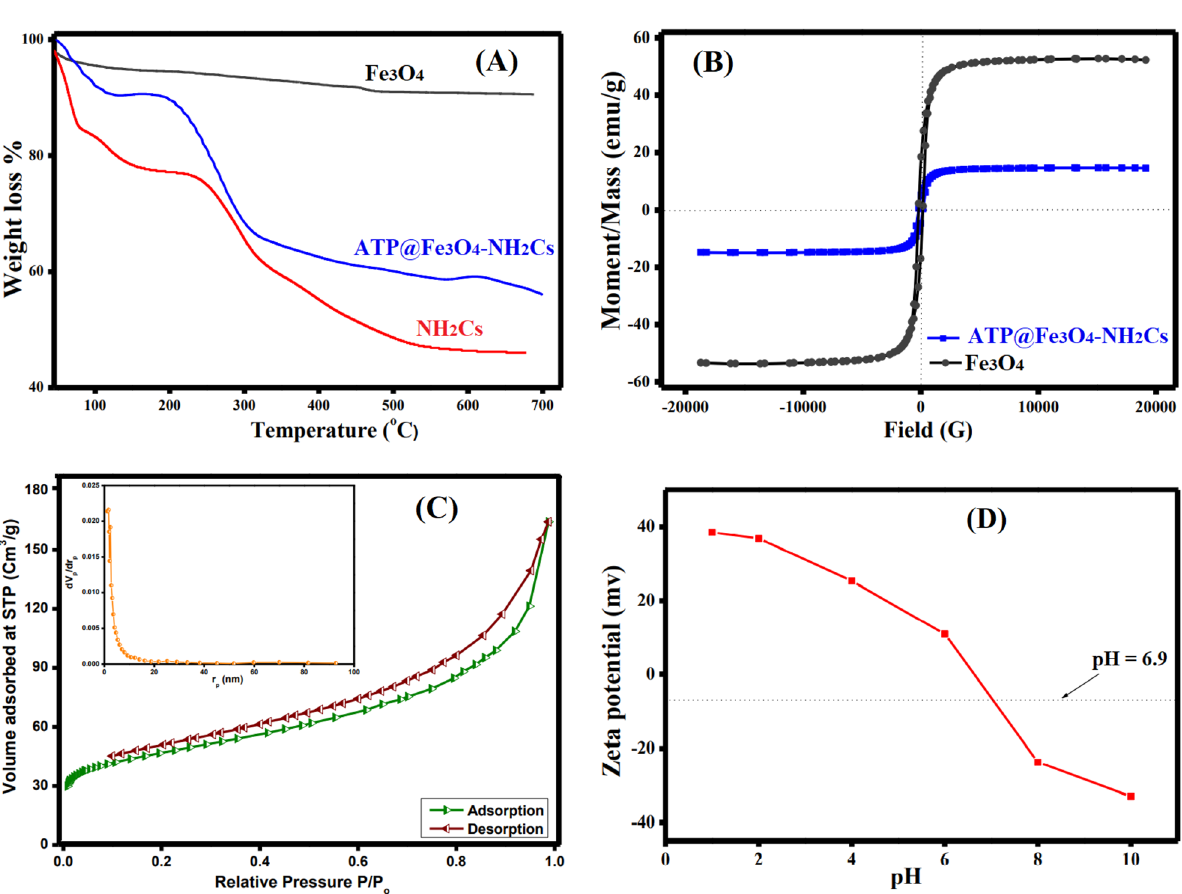
Figure 5. ( A ) TGA of Fe 3 O 4, NH 2 Cs and ATP@Fe 3 O 4 -NH 2 Cs composite, ( B ) VSM of Fe 3 O 4 and ATP@Fe 3 O 4 -